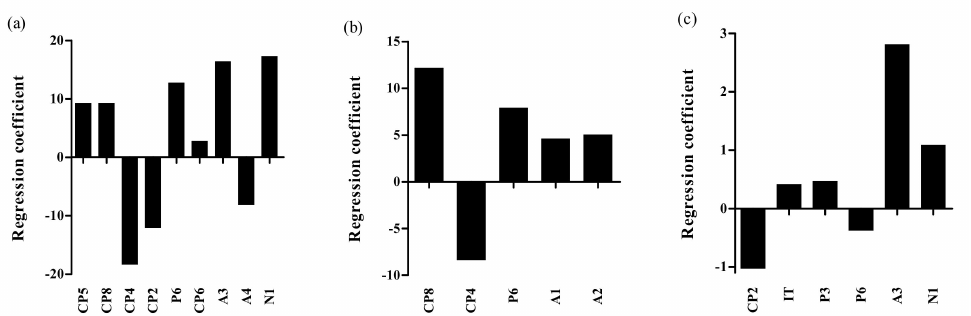
Figure 3. Effect of the main individual components and hydrocarbon families on fluidity properties. ( a ) freezing point, ( b ) Tco, and ( c ) viscosity at − 20 ◦